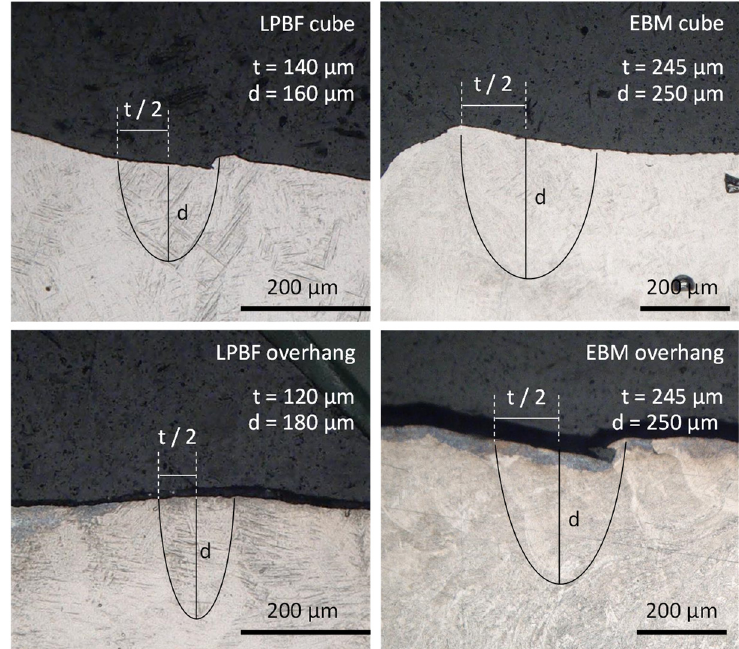
Figure 6. Melt-pool shape and sizes of LPBF and EBM samples.